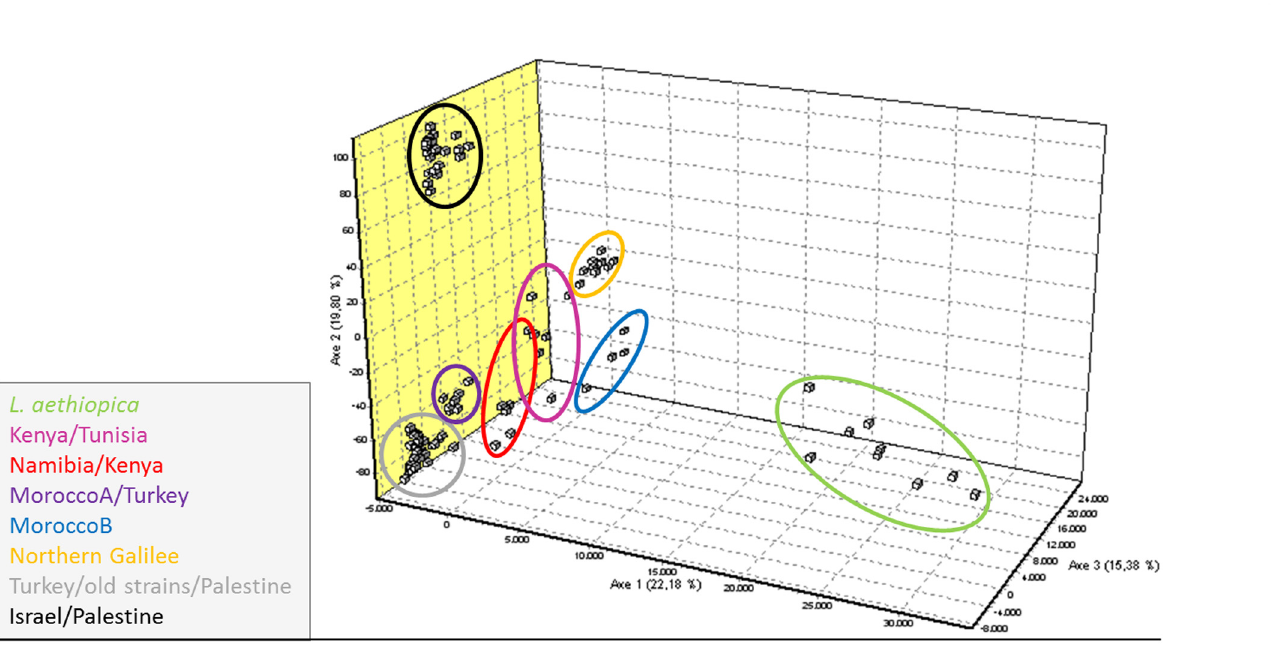
Fig 3. Factorial correspondence analysis (FCA) of the nine sub-populations. FCA displays the calculated genetic distances 3-dimensionally based on allele similarities. Each square represents one genotype. The colours correspond to clustering based on Bayesian statistical results. The software requires pre-assignment to single populations, therefore strains were assigned to the nine sub-populations proposed by